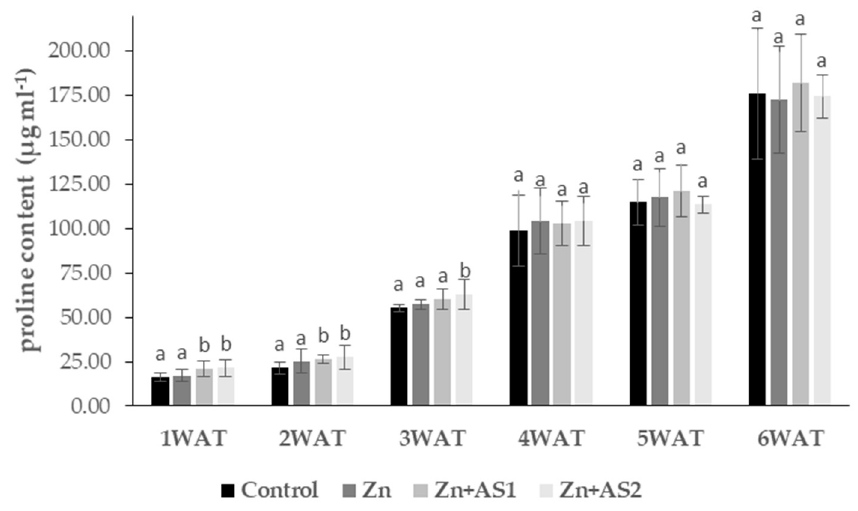
Figure 6 The effect of different foliar treatments (Zn, Zn+AS1, and Zn+AS2) on the proline content in corn leaf, n = 12 ± S.D. Lower case letters (a, b) show the significant differences among treatments based on the independent t-test ( p < 0.05). AS: amino acid; FW: fresh weight; Zn: zinc; WAT: week(s) after treatment.